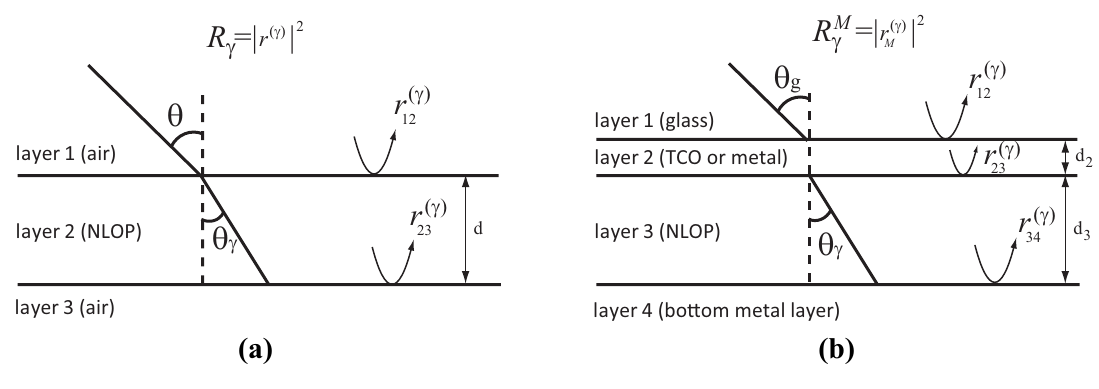
Figure 2. Schematics of two Fabry-Perot structures: ( a ) An ideal simple